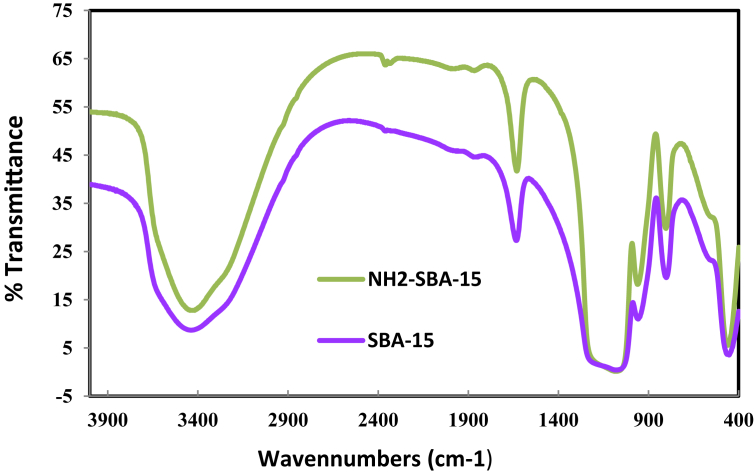
FTIR for SBA-15 & functionalized SBA-15-NH2.